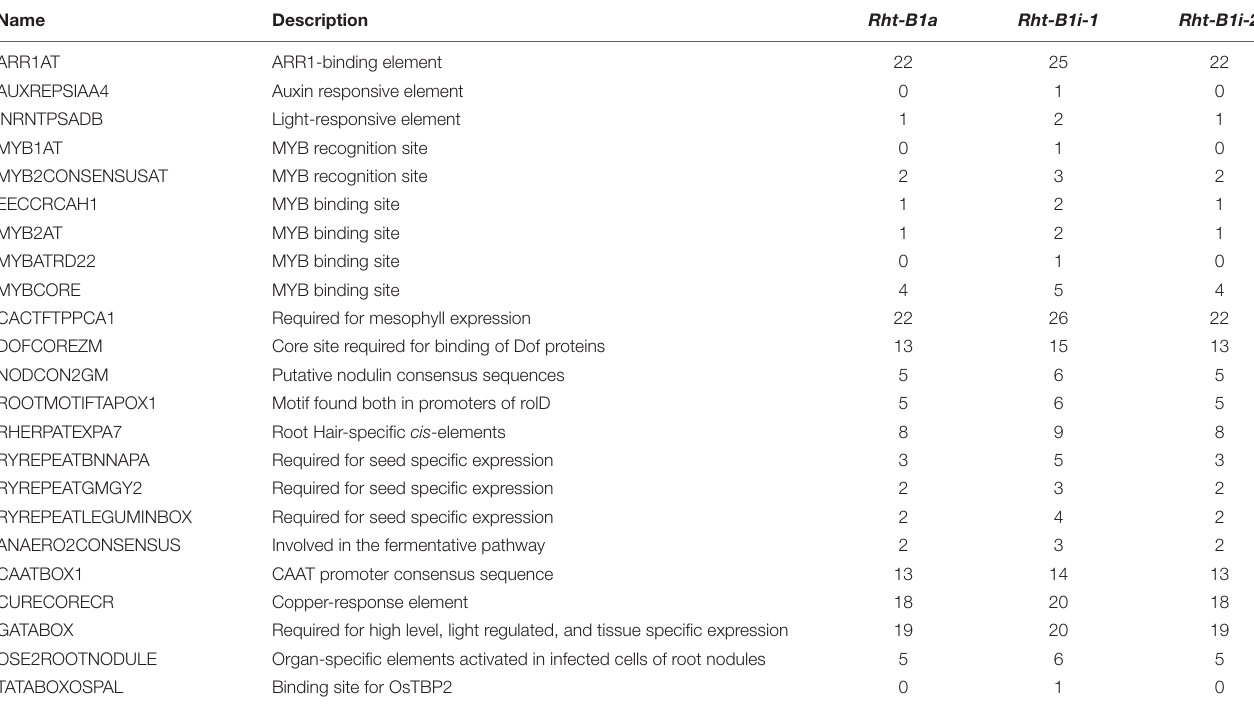
TABLE 1 | Cis -acting elements analysis of the promoter of Rht-B1a and